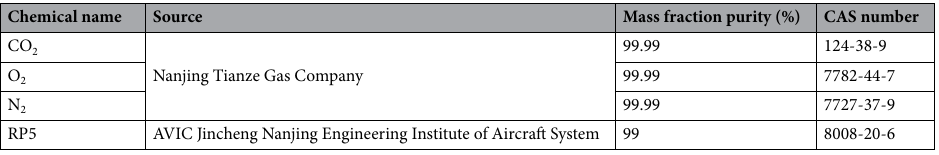
Table 1. Information on materials used in the experiment.